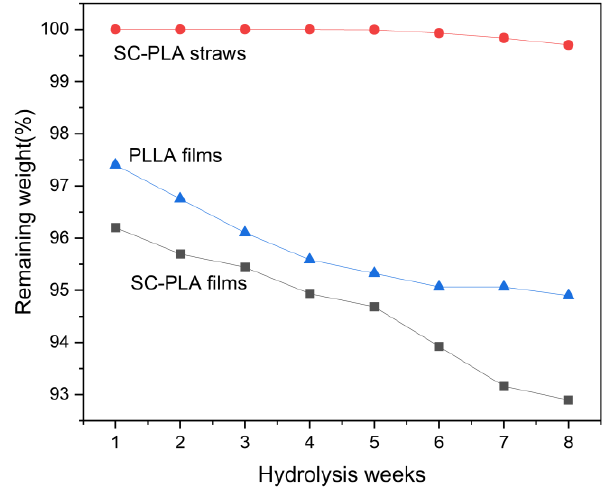
Figure 6. Remaining weights of films and straws as a function of hydrolysis time. Table 4. Estimated cost of SC-PLA